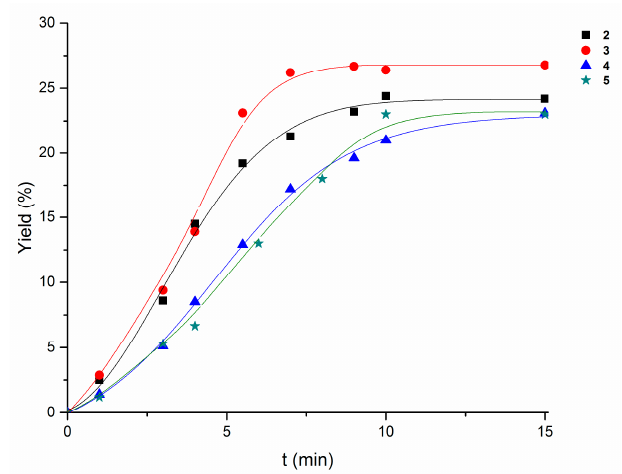
Figure 4. Comparison of the accumulation of oxygenates with time (0–15 min) in the cyclooctane (initial concentration 0.25 M) oxidation with H 2 O 2 (1.2 M), in the presence of pyridine (0.072 M), catalyzed by 2 – 5 (10 − 3 M) in acetonitrile at 60 °C.